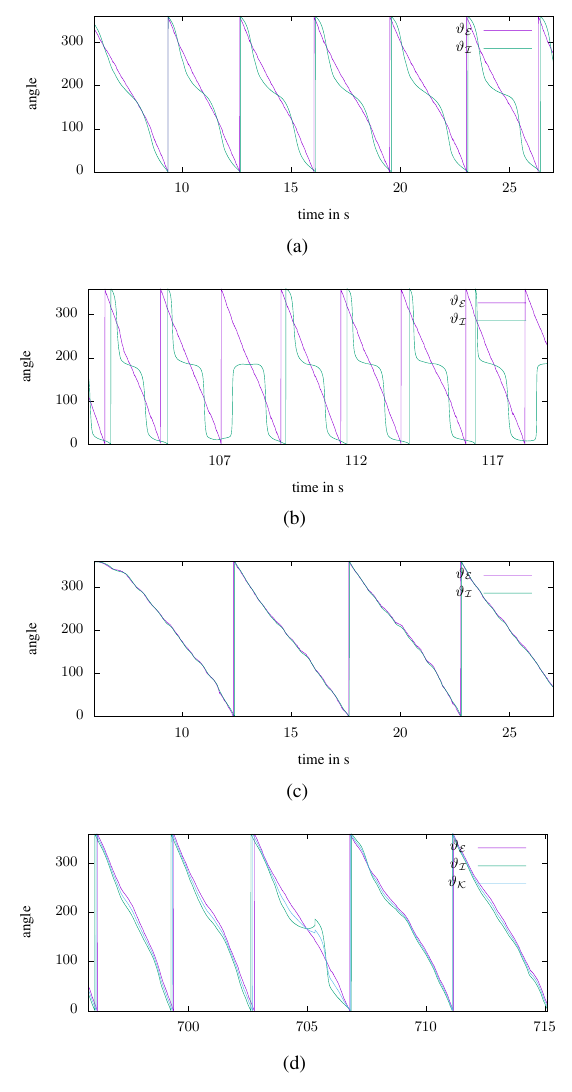
Figure 4. Comparing the pitch computed from encoder ϑ E , IMU ϑ I and fused using a Kalman filter ϑ K .